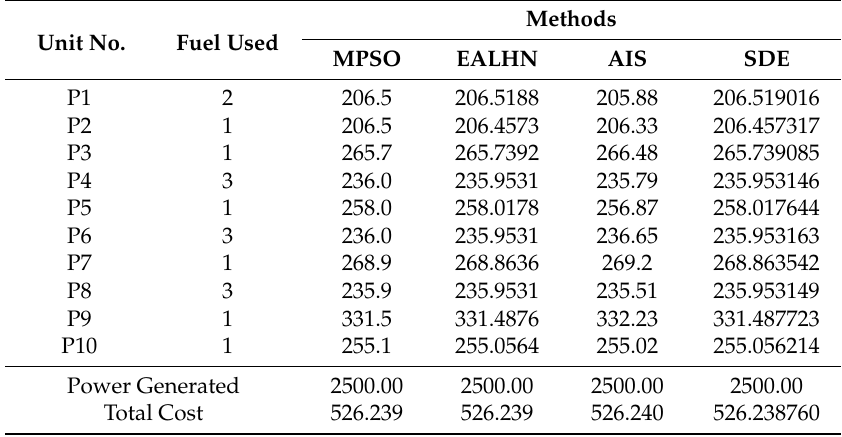
Table 3. Cost comparison among various methodologies for System 1, P d = 2500 MW.